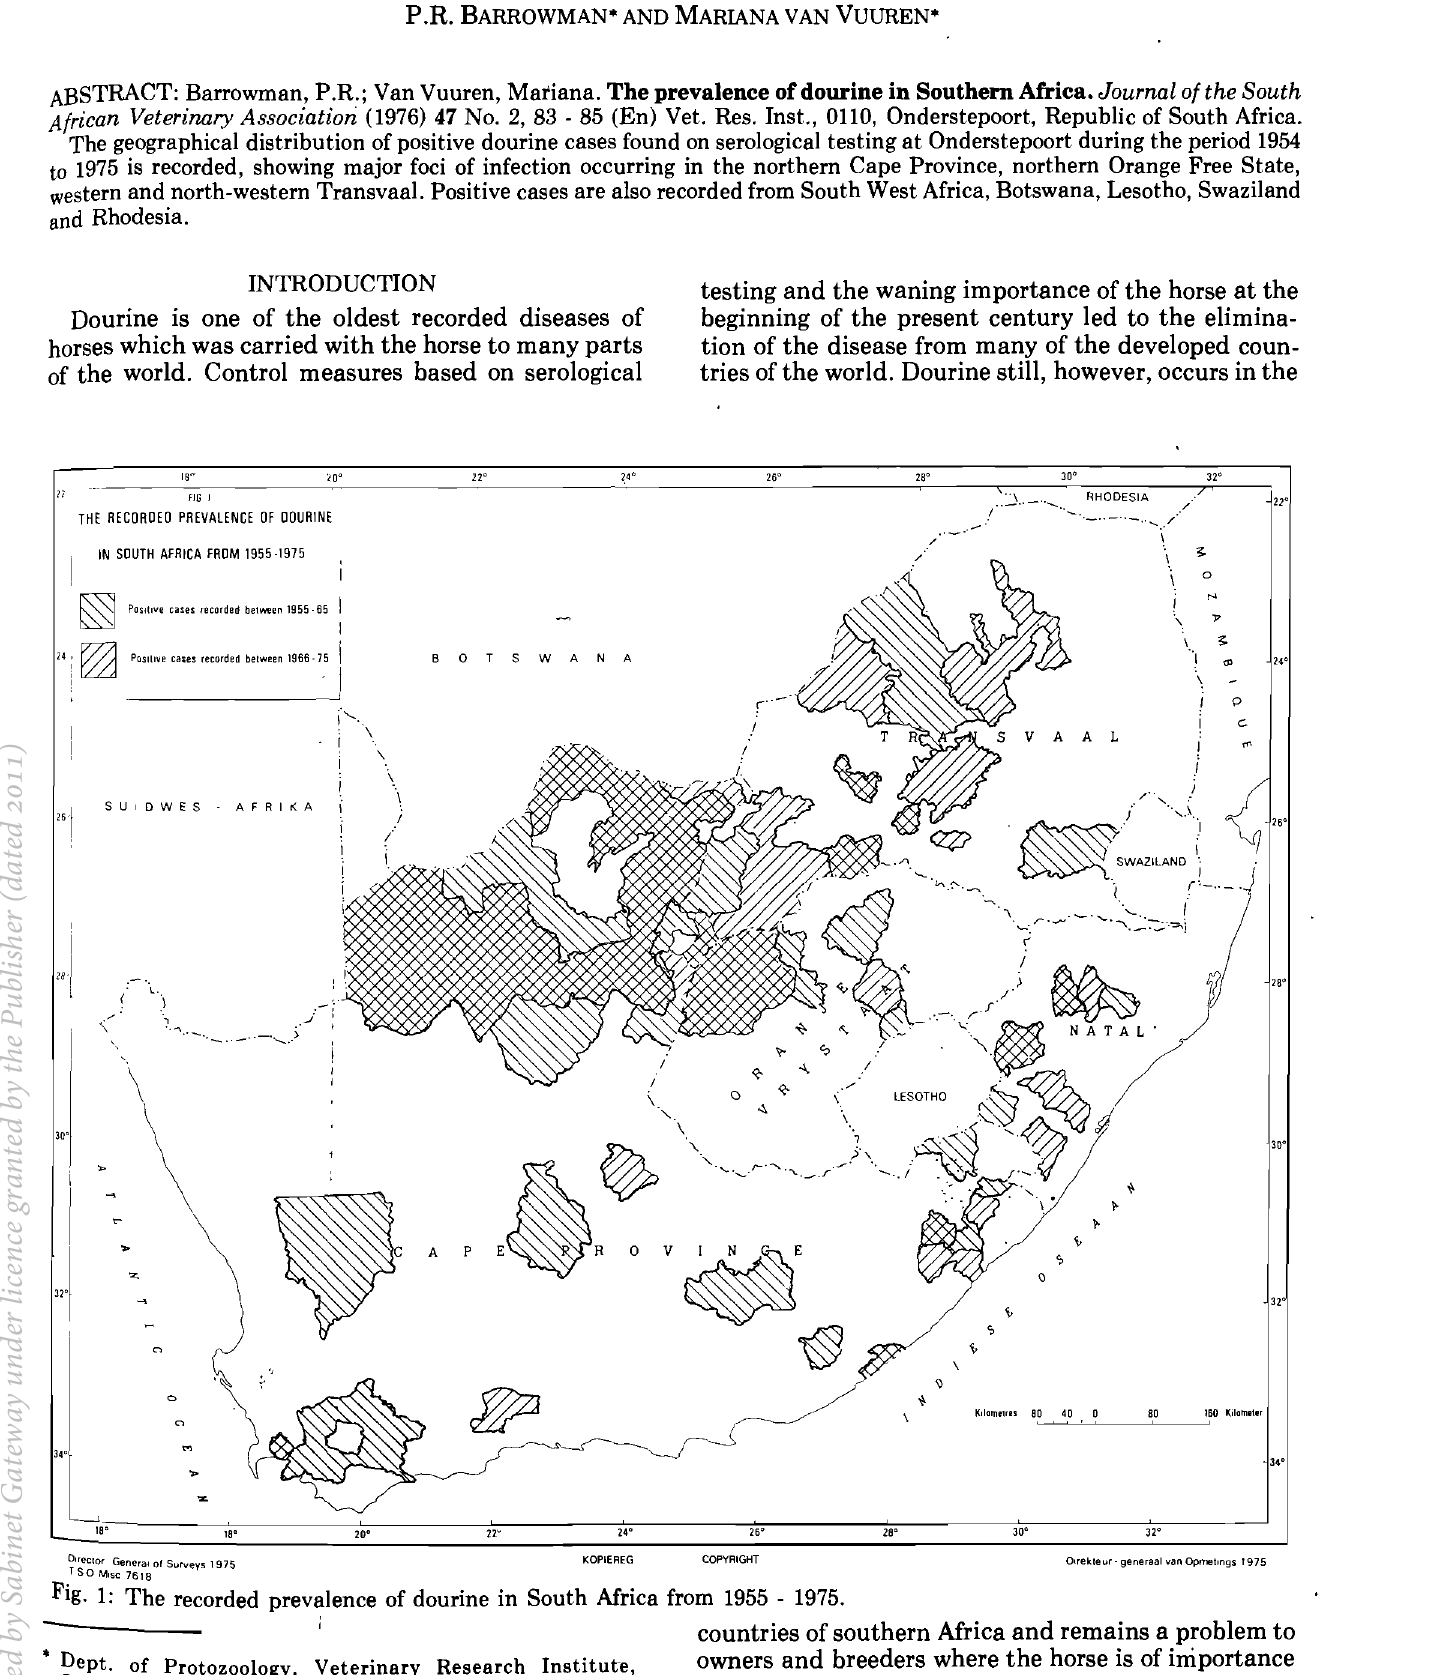
Fig. 1: The recorded prevalence of dourine in South Africa from 1955 -